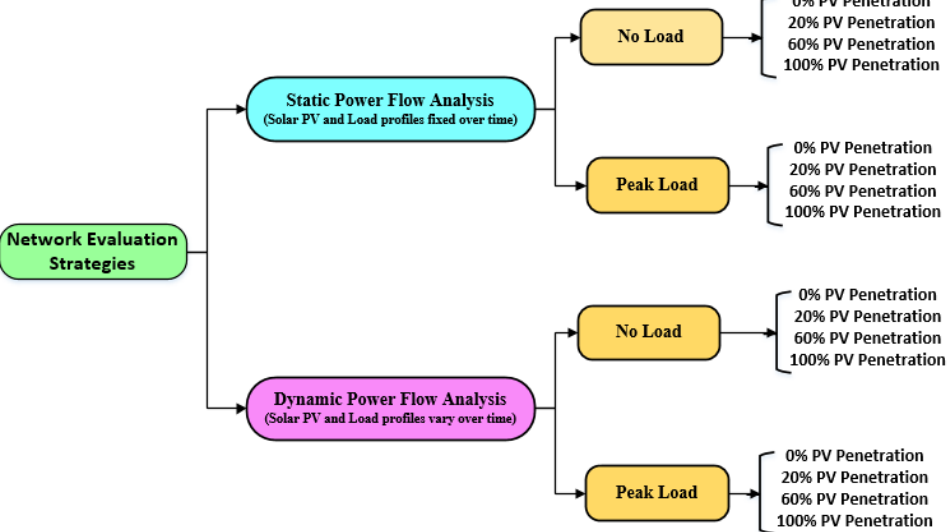
Figure 2. Strategies for Evaluating Networks: Static and dynamic analyses were conducted to assess the network’s performance in periods of peak load and in no-load situations among cases 1,2, and 3.